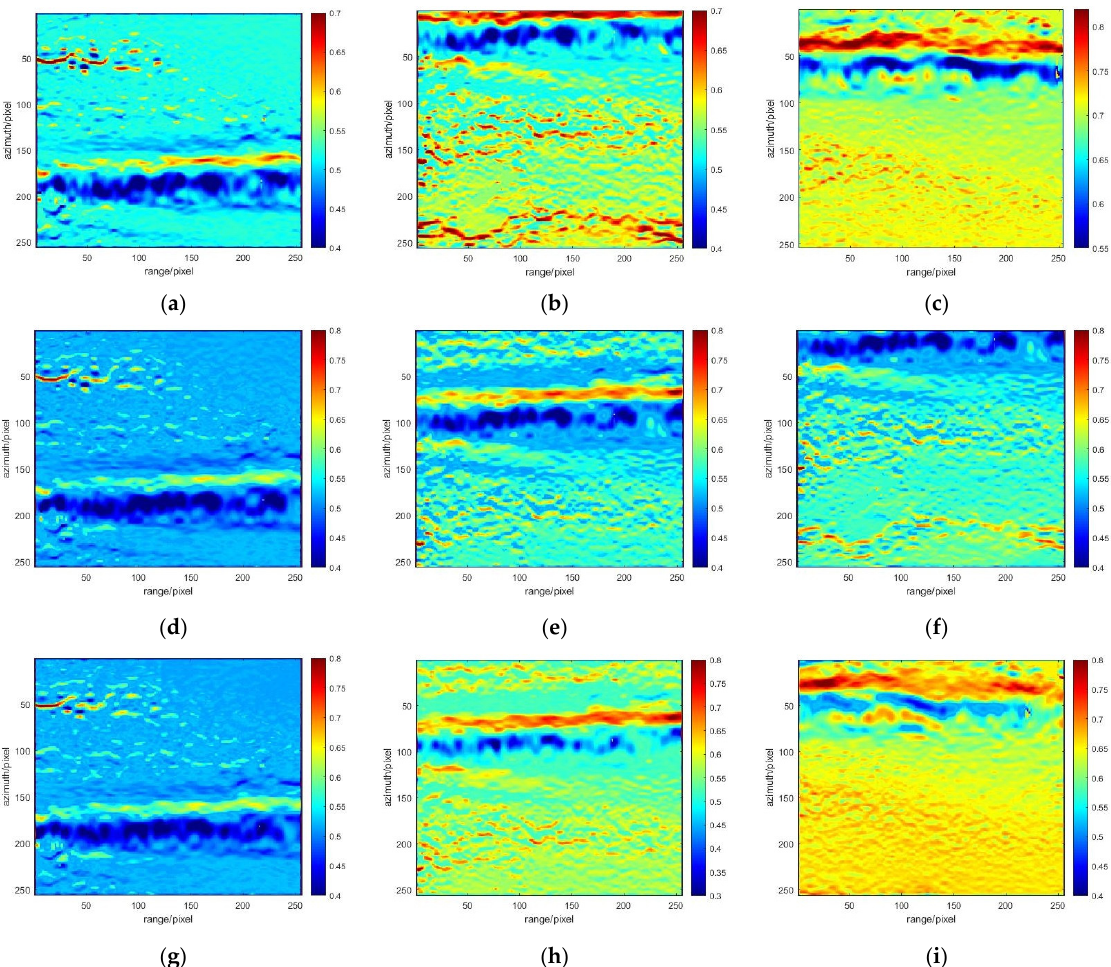
Figure 5. The input ocean surface current field velocity: ( a ) sample 1, ( b ) sample 2, ( c ) sample 3, ( d ) sample 4, ( e ) sample 5, ( f ) sample 6, ( g ) sample 7, ( h ) sample 8, and ( i ) sample 9.